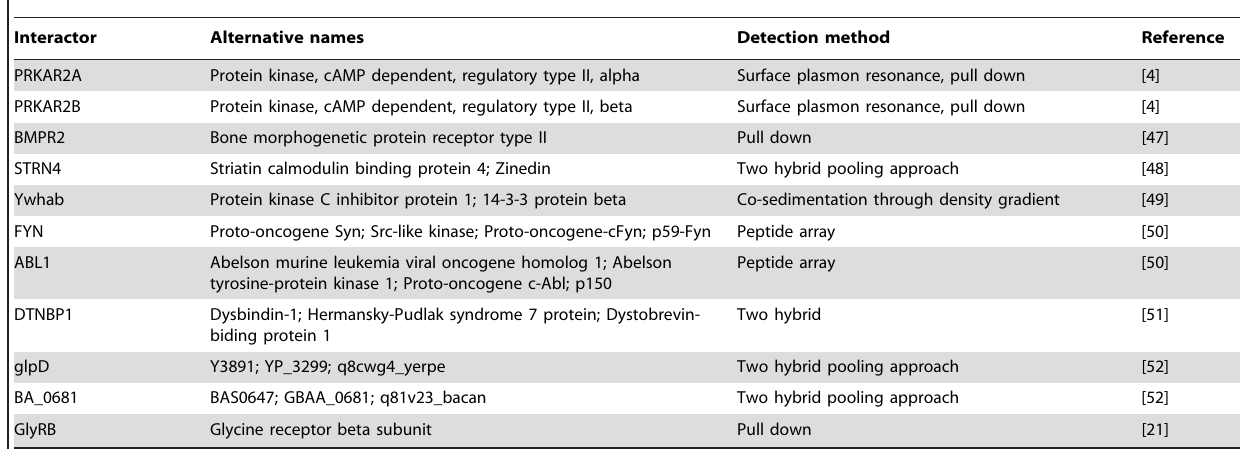
Table 1. Previously identified binding partners of Nbea.